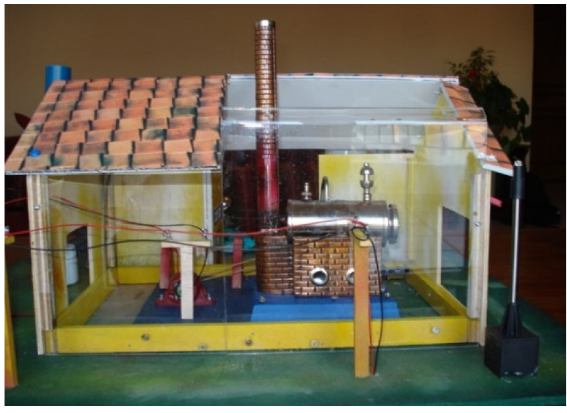
Figure 3. A prototypical 3-D representation of a